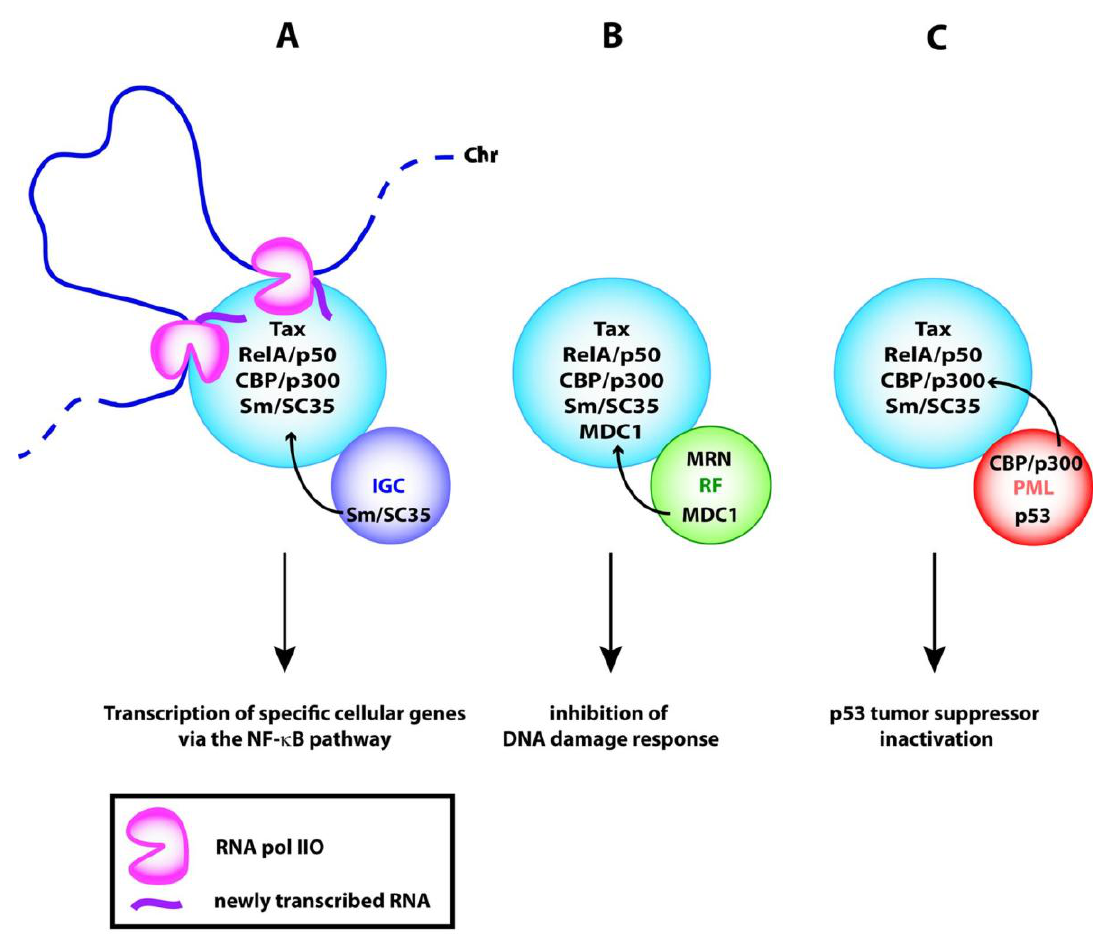
Figure 5. Potential functions of Tax NBs ( A ) in transcription ( B ) in sequestration of DNA repair effectors and ( C ) in sequestration of modification enzymes involved in